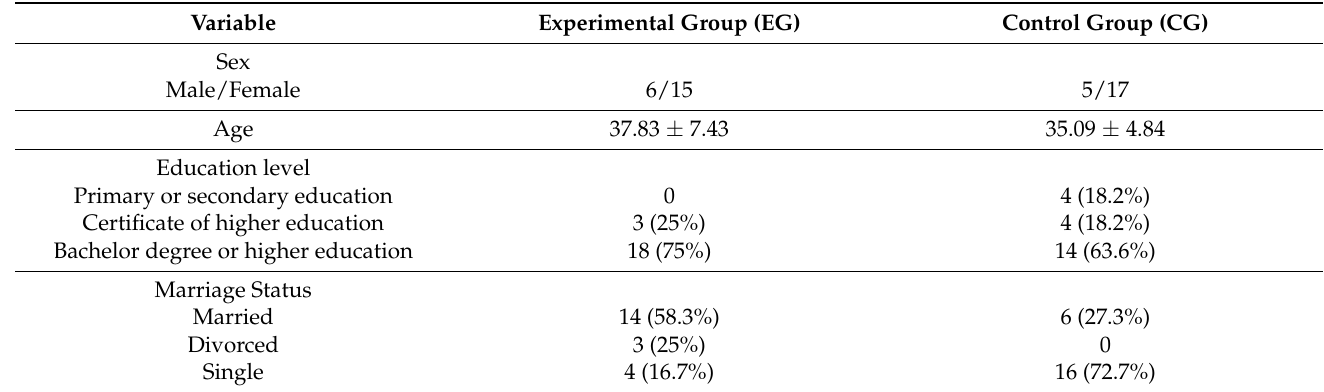
Table 1. Sociodemographic characteristics of participants.